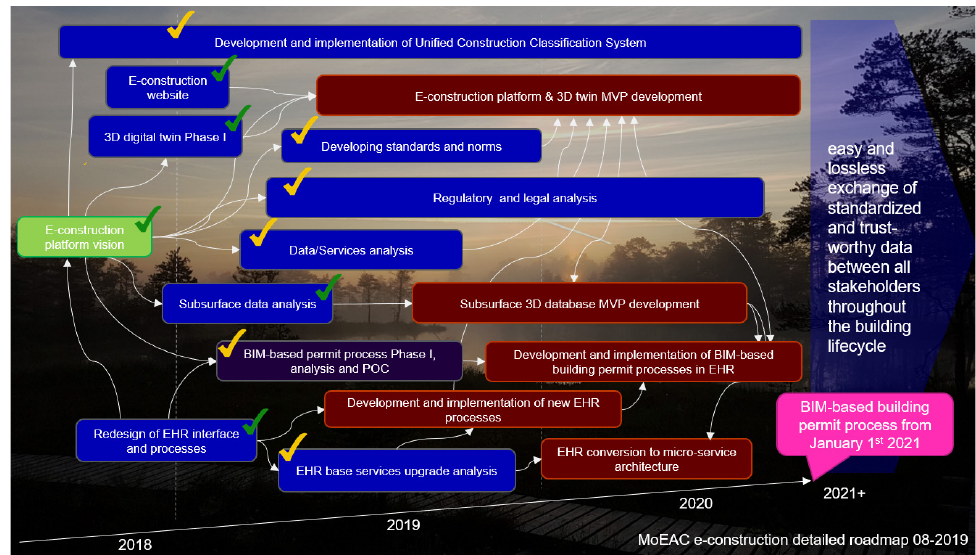
Figure 2. MoEAC detailed roadmap for BIM-based building permit process (source: Estonian Ministry of Economic Affairs and